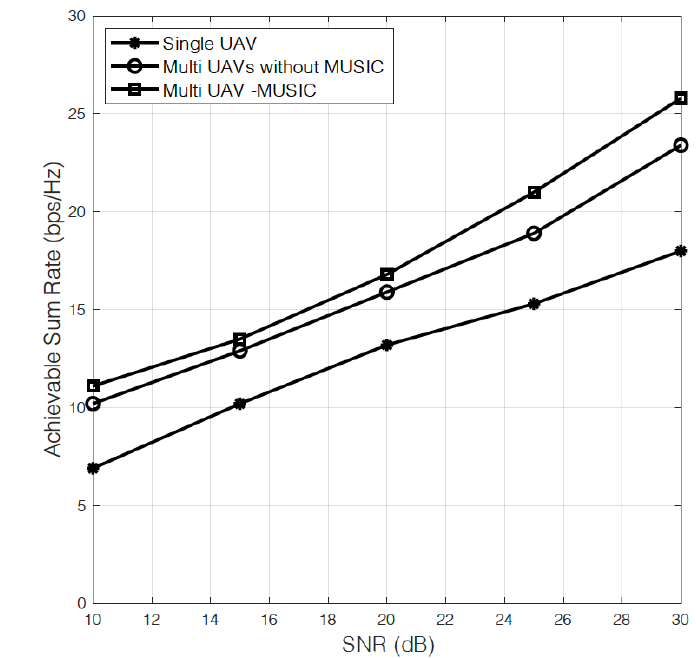
Figure 3. Achievable rate for multiple UAVs and a single UAV in LOS environment.